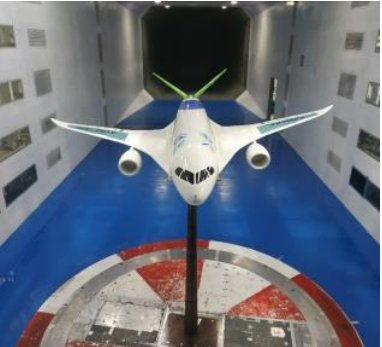
Figure 5. Installation of the model in the wind tunnel virtual flight test. Table 4. Ontology design parameters of the test model.